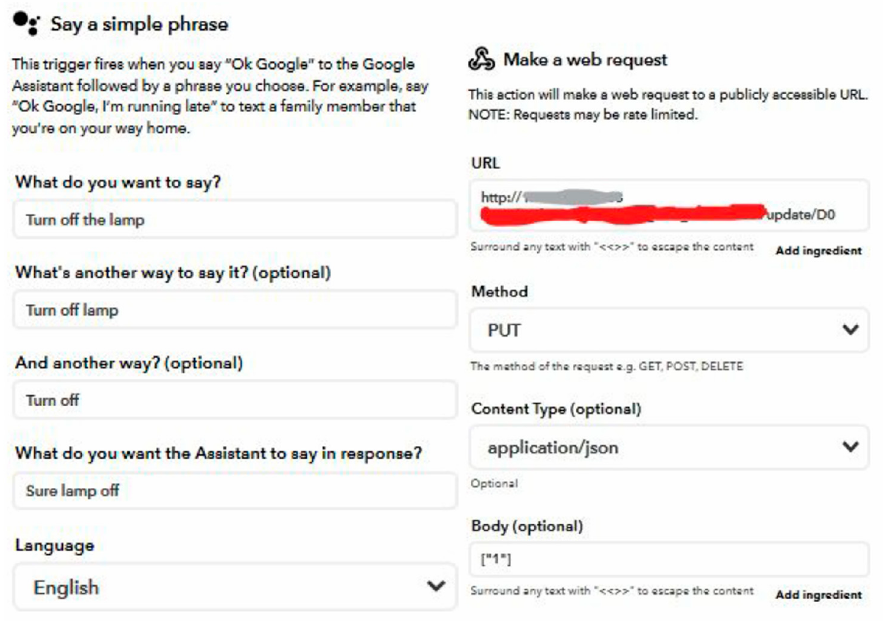
Figure 5. If This Then That (IFTTT) trigger turn